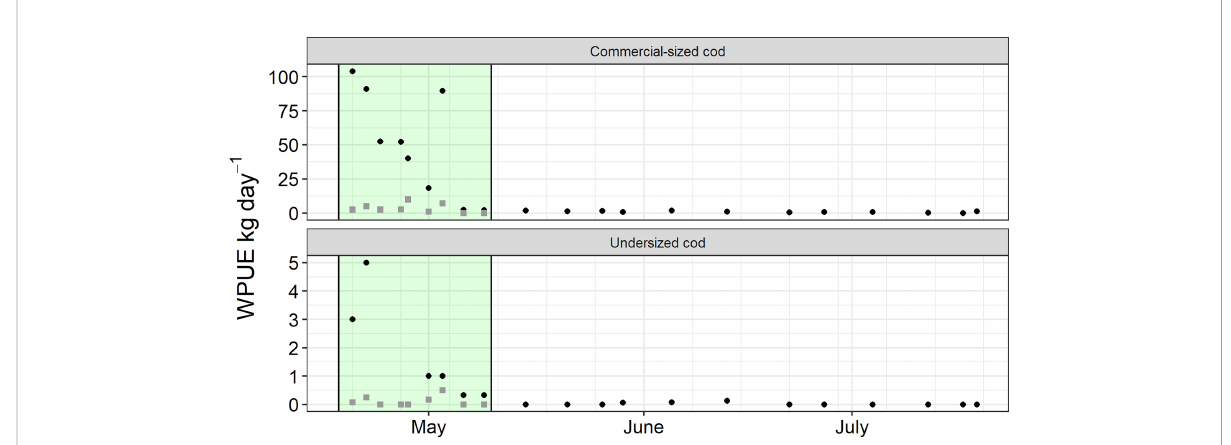
FIGURE 3 Mean WPUE (kg day -1 ) of commercial sized and undersized cod (Gadus morhua) in the two traps tested for difference in leader net mesh size. Black circles represent the pontoon trap equipped with 100 mm leader net, while grey squares represent the pontoon trap equipped with 60 mm leader net. Green background indicates the time period when both traps were simultaneously